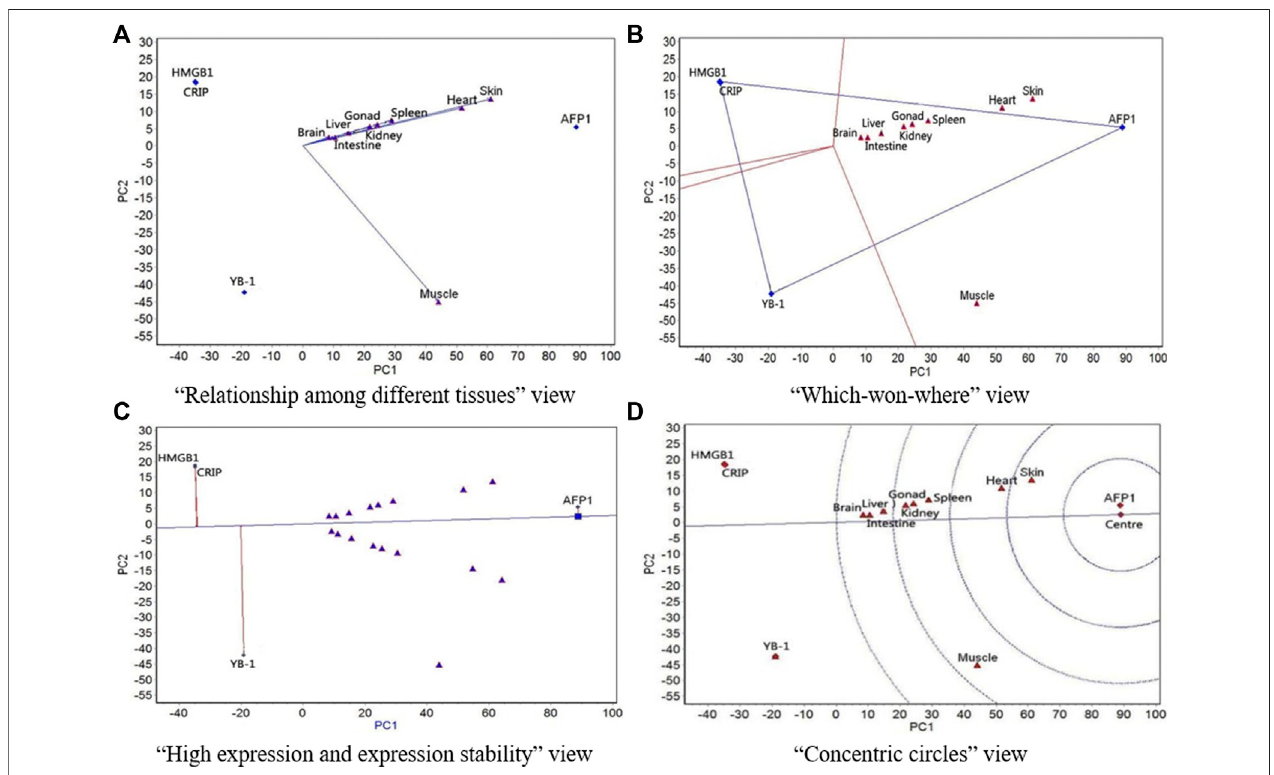
FIGURE 2 | The GGE biplot for expression of four resistance genes to low temperature (AFP1, CIRP, YB-1, and HMGB1) in different tissues at 5 ° C. (A) “ Relationship among different tissues ” view. (B) “ Which-won-where ” view. (C) “ High expression and expression stability ” view. (D) “ Concentric circles ” view.